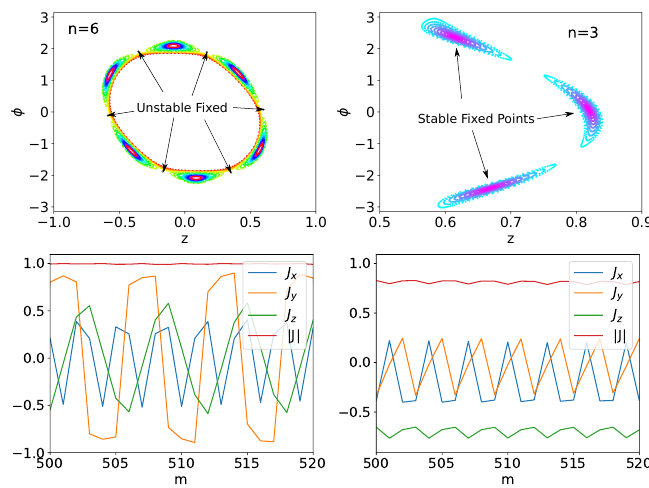
Figure 2: Stroboscopic classical Poincaré section (top) and exact stroboscopic quan- = 10, Λ = 0: with ( t ) = ( 0.35,0.2 ) tum dynamics (bottom) for N = 500, Λ , t 1 2 1 2 (left), and ( 0.3,0.1 ) (right). The color (brightness) in the top plots distinguishes the initial state. The top plot depicts the emergent classical fixed points for n = 6 (left), and n = 3 (right). In the bottom plots, we show the n = 6 and n = 3 subharmonic oscillations due to U moving between the different emergent fixed points. | J | is plot- 1 ted to illustrate that the fixed points stabilize the system against quantum dephasing. In the top left Poincaré plot, we have also highlighted the n unstable fixed points that generically occur in addition to the stable fixed